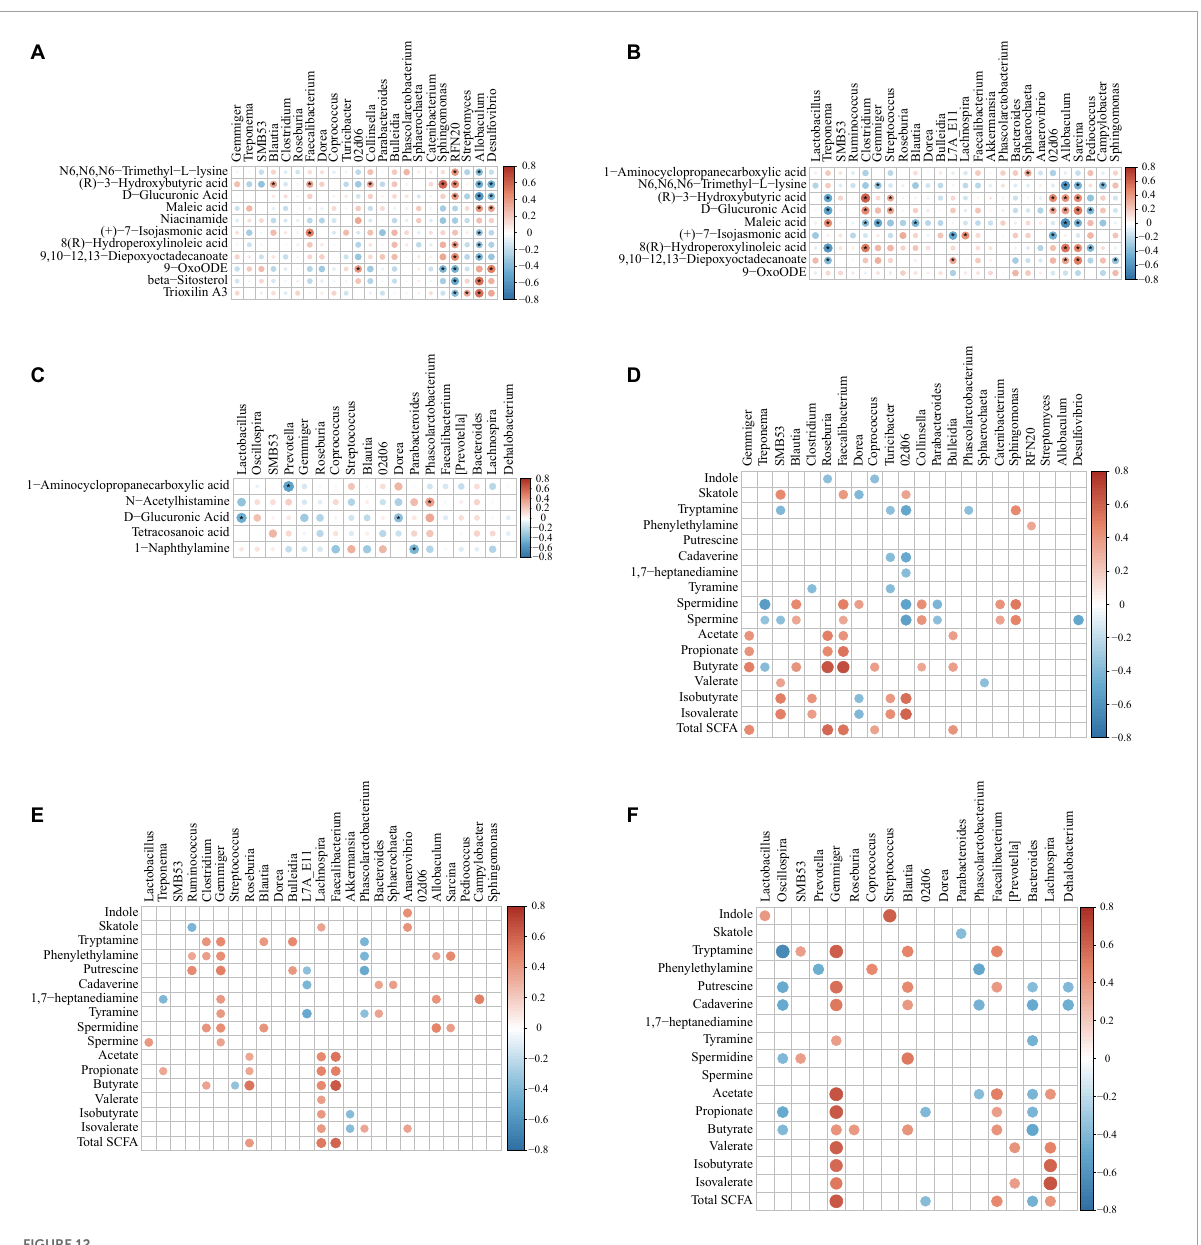
FIGURE12 Spearman correlation analysis of different microbiota and metabolites [from metabolomic analysis, (A–C) indole, skatole, SCFAs, and bioamine, (D–F) ] in colonic contents of offspring pigs at 65, 95, and 125 days of age, respectively. The red represents positive correlation while the blue represents negative correlation. Asterisk (A–C) and red or blue circle (D–F) represents P -value <